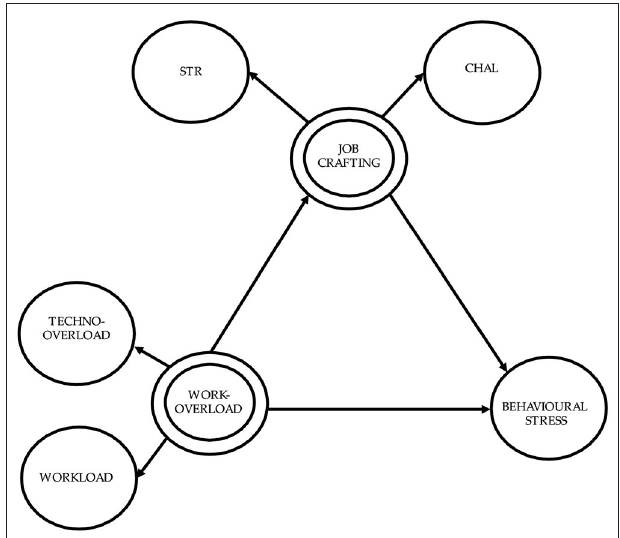
FIGURE 1 | The overall structural model explored. STR, Increasing structural resources; CHAL, Increasing challenging demands.